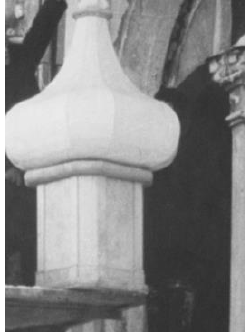
Figure 3. Basic model for a 3D shape reconstruction of a cupola on lantern. Scale 1:5, placed on scaffolding at a relative height © Boris Lobovikov archive